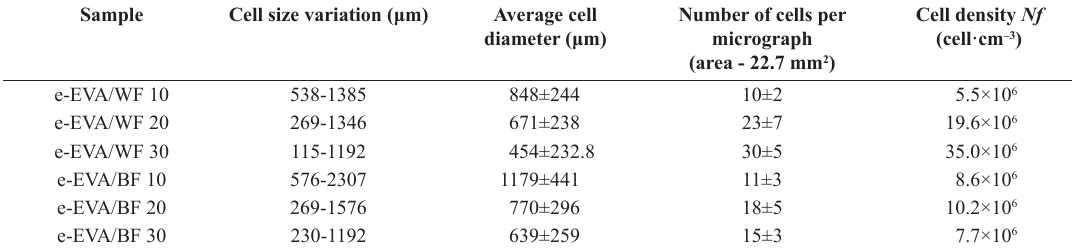
Table 2. Cell size frequency distribution in the cellular composites.